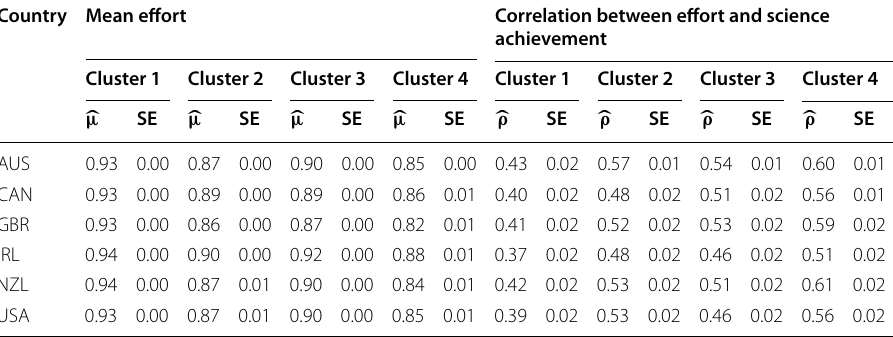
The subsample of students who had a total RT lower than 3000 s is composed of 86.30% (first session) and 92.30% (second session) of the students of the total sample